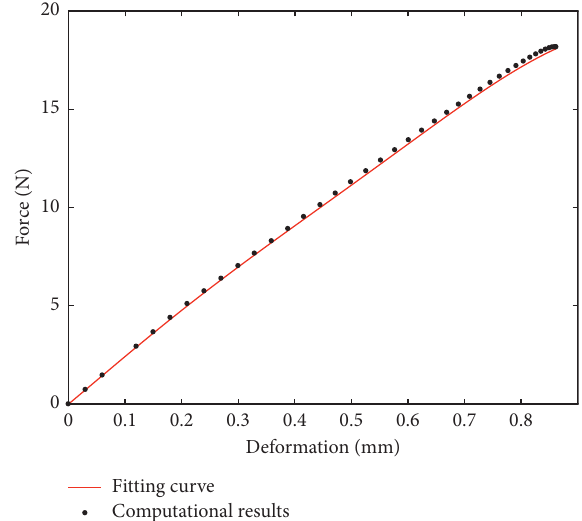
Figure 10: Fitting curve of the grasping environment contact force